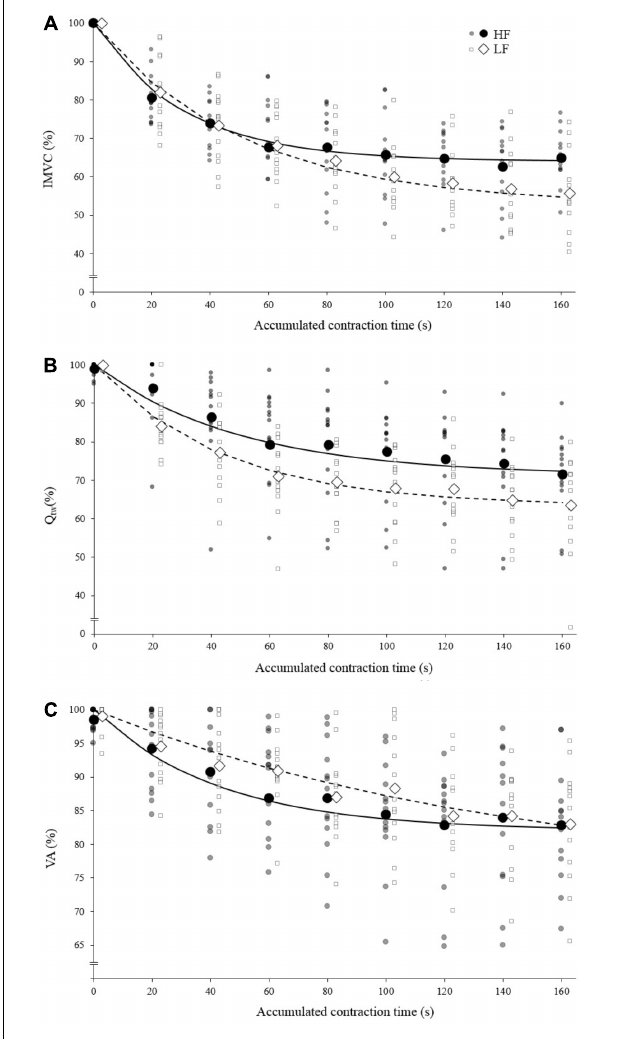
FIGURE 2 | Mean fatigue kinetics for isokinetic knee extensions performed with high force (HF; black) and low force (LF; white). Individual data are represented by the small markers. (A) Torque (Isometric Maximal Voluntary Contraction) – time relationship. (B) Evoked torque (Q tw ) – time relationship. (C) Voluntary activation (VA) – time relationship; IMVC, Q tw and VA are expressed as a percentage of the maximal value. The solid/dotted line corresponds to exponential modeling of the relationship for HF and LF, respectively. Markers representing HF and LF conditions are slightly shifted for a visualization